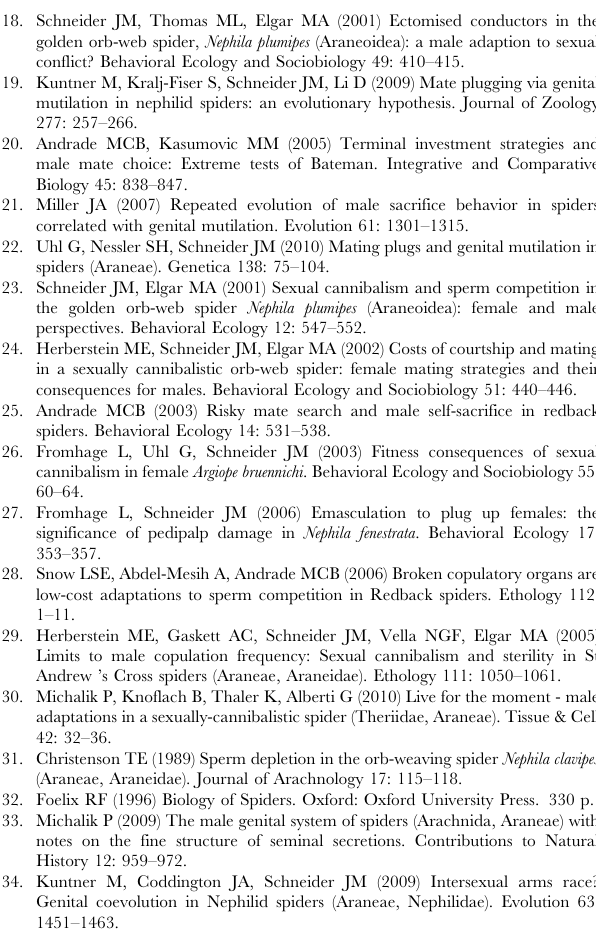
Table S1 Real age (number of days after penultimate or final molt when sacrificed) and standardized age (age relative to the youngest sub-adult male) for all males in the study. For following standardized age more than one specimen was used: 43, 59, 77, 78. Dataset S1 Matrix and phylogenies used for the